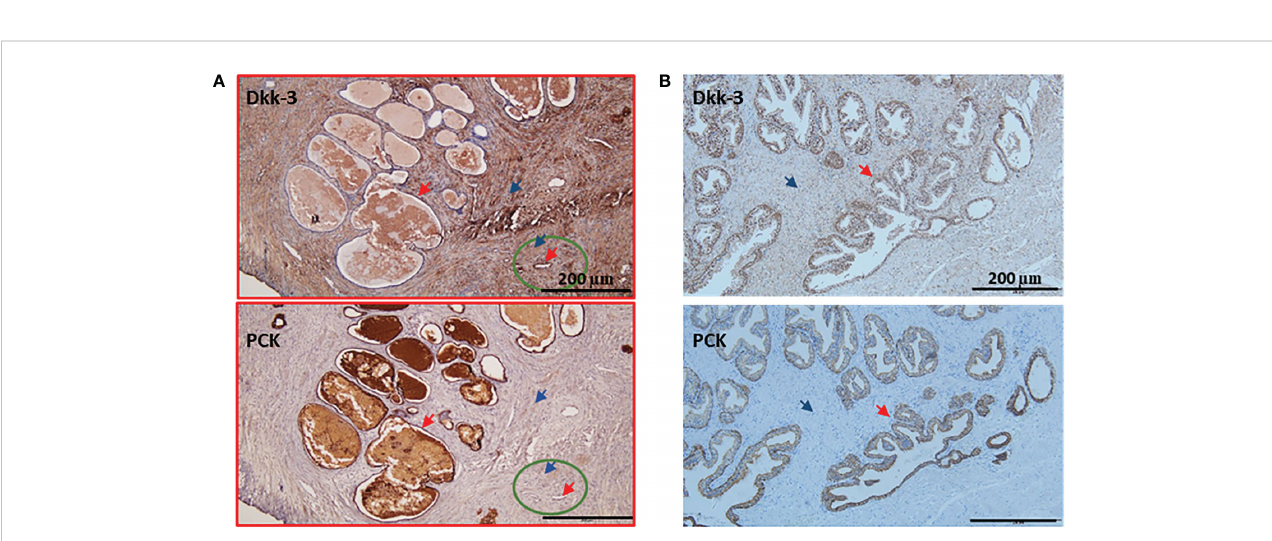
FIGURE 4 Examples of patient's IHC with lower expression of Dkk-3 in cancer compared to normal epithelium. (A) Gleason 8 prostate cancer patient was stained with Dkk-3 and Pan cytokeratin (PCK), the majority of the section shows a tumor (red frame), the normal adjacent tissue (green circle), the epithelium (red arrow), stroma (blue arrow). (B) Benning prostate hyperplasia patient was stained with Dkk-3 and Pan cytokeratin (PCK), the epithelium (red arrow), stroma (blue arrow), and scale bars 200 m m.